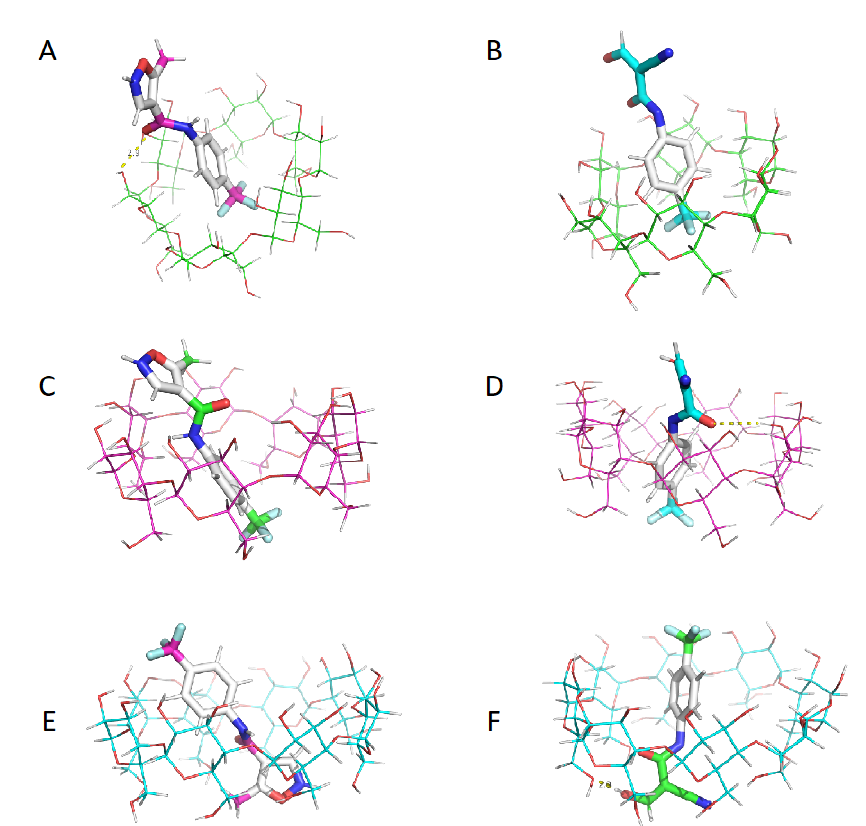
Figure 5. Docking results obtained for ( A ) α -CD / LEF, ( B ) α -CD / TEF, ( C ) β -CD / LEF, ( D ) β -CD / TEF, ( E ) γ -CD / LEF and ( F ) γ -CD / TEF. Cyclodextrin core is represented with thin lines and hydrogen bonds with yellow dashes.